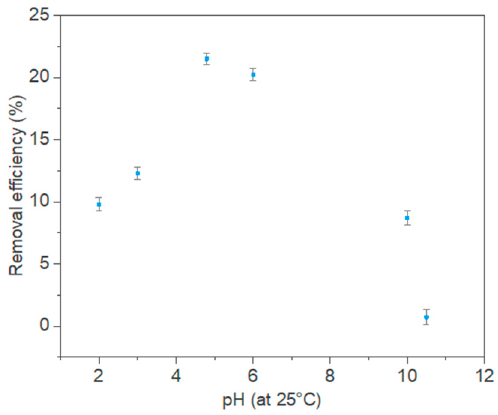
Figure 2. E ff ect of pH on adsorption of PCs by the PDMS / oxMWCNTs sponge. Figure 2. Effect of pH on adsorption of PCs by the PDMS/oxMWCNTs sponge.